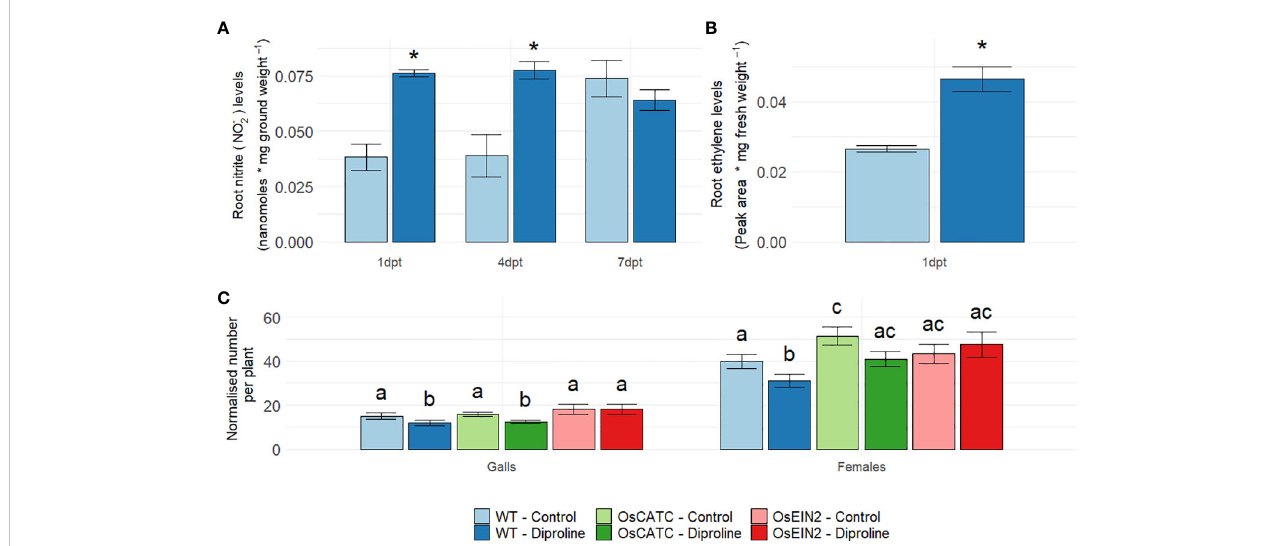
FIGURE 3 Ethylene and nitric oxide mediate diproline-induced resistance in rice. (A) Root nitrite ( NO − 2 ) levels, one, four and seven days post foliar treatment with water (control) or 500 µM diproline (1 dpt, 4 dpt and 7 dpt, respectively) (n = 5). (B) Root ethylene levels at 1 dpt (n = 5). (C) Normalized number of galls and female nematodes per plant, as assessed fourteen days after inoculation with 250 Meloidogyne graminicola second-stage juvenile nematodes (n = 16). One day before inoculation, plants were treated with water (control) or 500 µM diproline. OsCATC is defective in CATALASE C (Os03g0131200). OsEIN2 is an RNAi-line of ETHYLENE-INSENSITIVE PROTEIN 2 (Os07g0155600). Error bars represent the standard error of the mean. (A – C) . In subpanels, a and b, asterisks indicate a signi fi cant difference from mock-treated plants according to a two-sided heteroscedastic t-test (p<0.05). In subpanel c, treatments with different letters are signi fi cantly different (p < 0.05), according to a non-parametric Mann-Whitney test